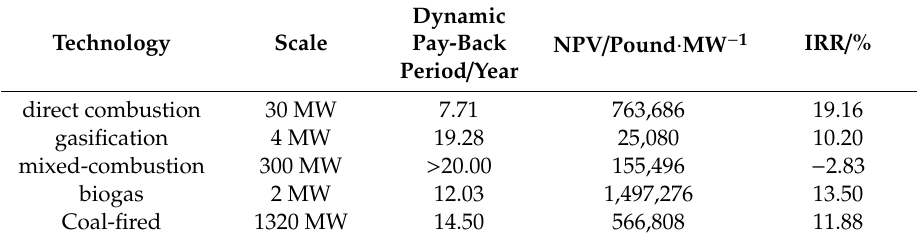
Table 9. Economic evaluation results of di ff erent power generation